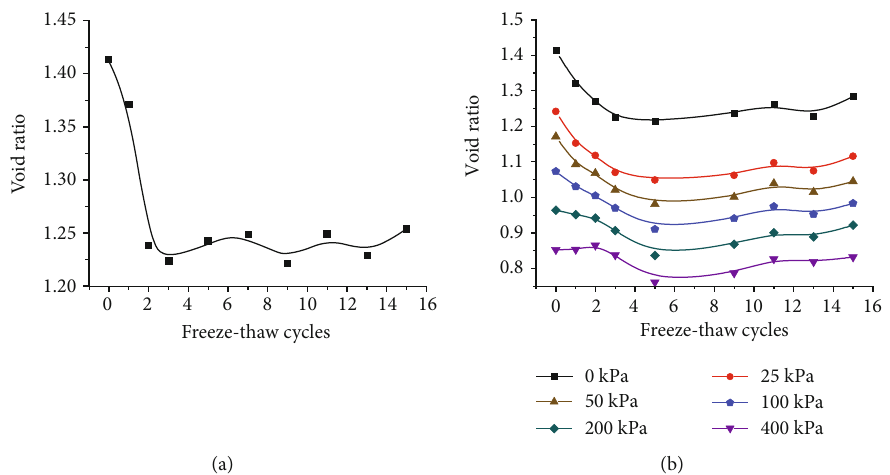
Figure 4: Variation of void ratio with di ff erent freeze-thaw cycles: (a) 0kPa and (b) 0 – 400kPa.